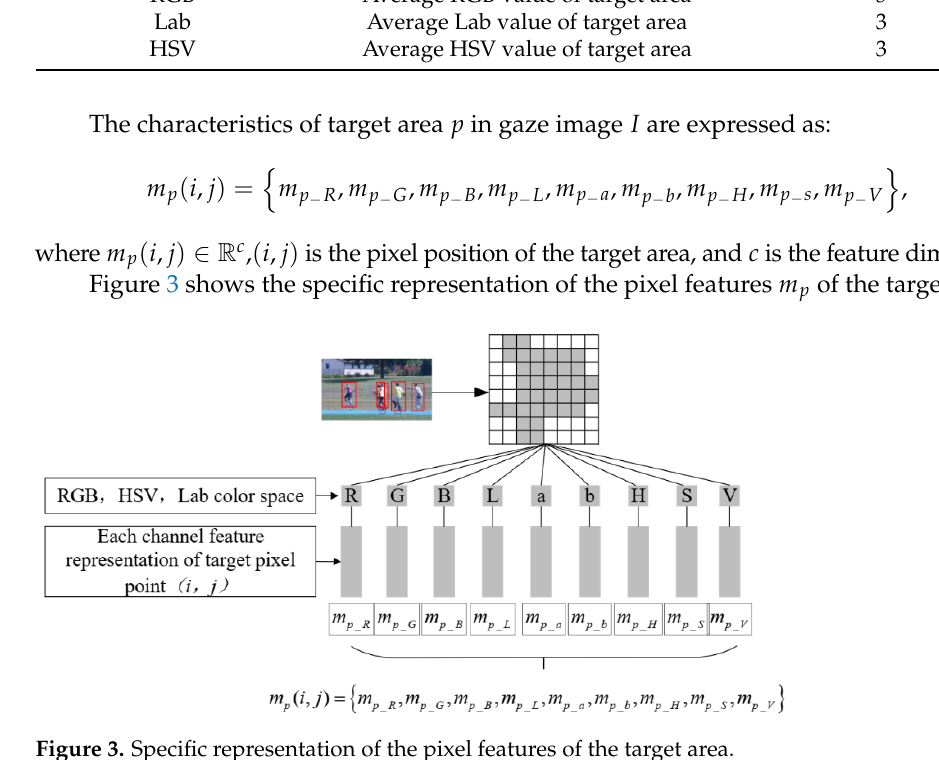
Figure 3. Specific representation of the pixel features of the target area.